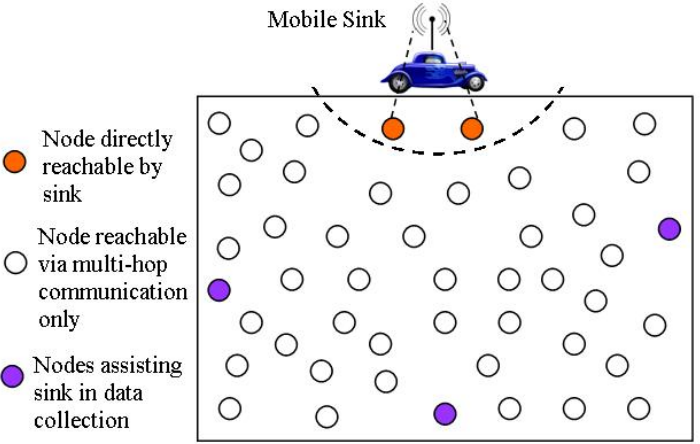
Figure 2. Network architecture of a mobile wireless sensor